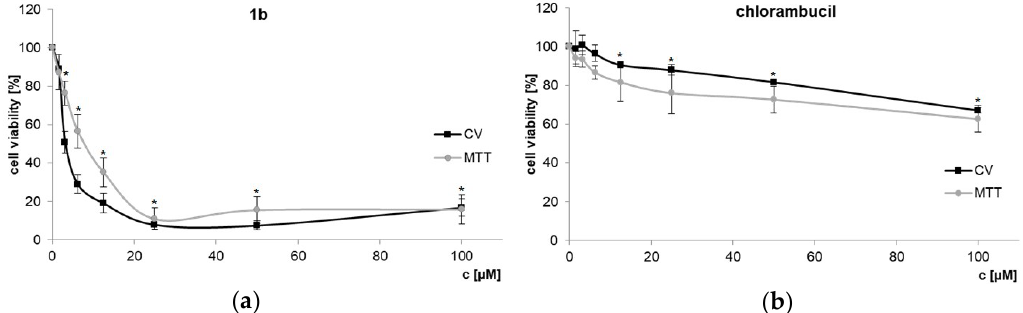
Figure 2 . Dose-dependent response of PC-3 cells treated with dendrimer 1b ( a ) and CLB ( b ). CV and MTT assays (72 h; 20 µM of dendrimer 1b corresponds to 80 µM of chlorambucil in toxic moieties) [33], * p < 0.05 refers to untreated cultures.